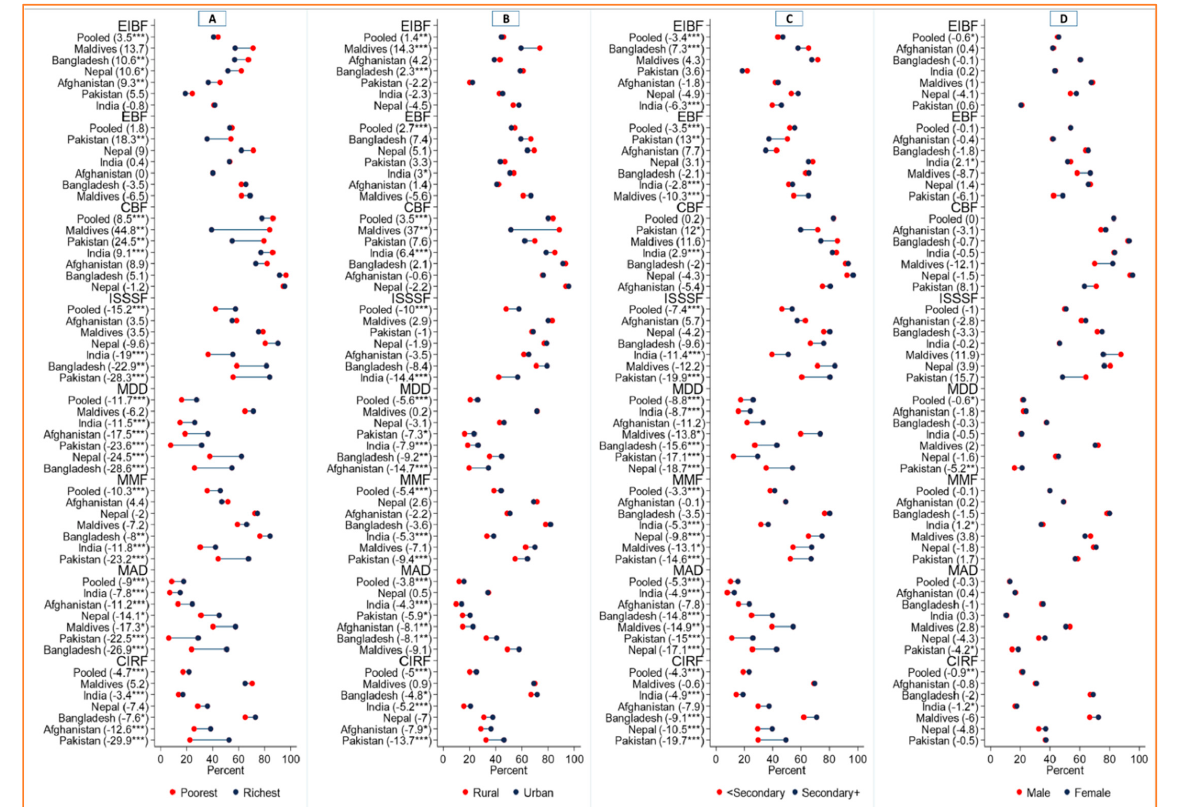
Figure 2. Absolute gaps in the prevalence of IYCF indicators across equity dimensions in South Asian countries. EIBF = Early initiation of breastfeeding, EBF = Exclusive breastfeeding, CBF = Continued breastfeeding at 1 year, ISSSF = Introduction of solid semi-solid and soft foods, MDD = Minimum dietary diversity, MMF=Minimum meal frequency, MAD = Minimum acceptable diet, CIRF = Consumption of iron-rich or iron-fortified foods. Note: Absolute gaps were calculated by subtracting the estimates/prevalence of IYCF indicators of the richest groups from the poorest (in panel ( A )), of urban from rural (in panel ( B )), of secondary+ education from below secondary education (in panel ( C )) and of female from the male (in panel ( D )). *** denotes p -value < 0.001, ** denotes p -value < 0.01, and * denotes p -value < 0.05.